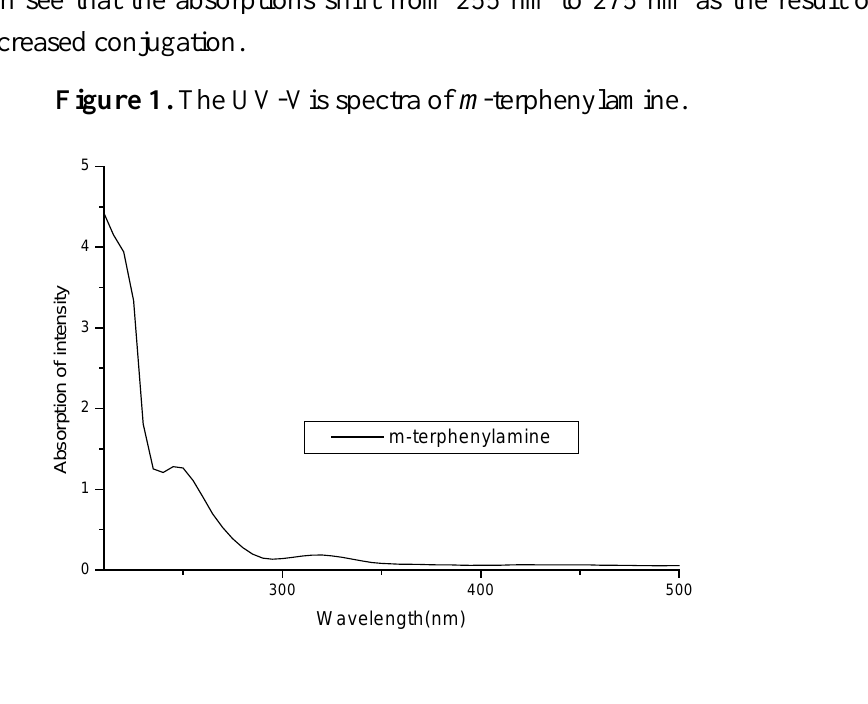
Figure 2. The UV-Vis spectra of 5,7-diphenylquinoline and